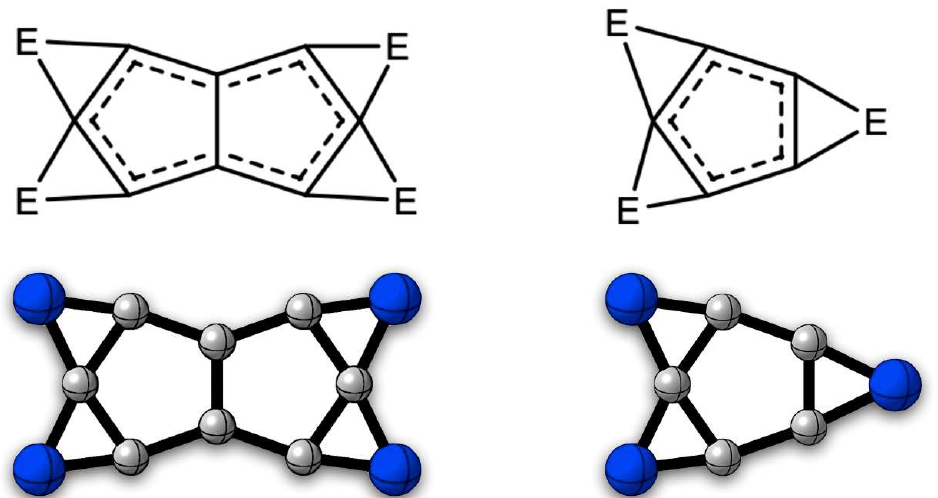
Figure 1. E 3 C 5 and E 4 C 8 (E = Si–Pb) systems proposed in reference [7], when E = Si and Ge structures correspond to the global minima (see bottom of the figure).